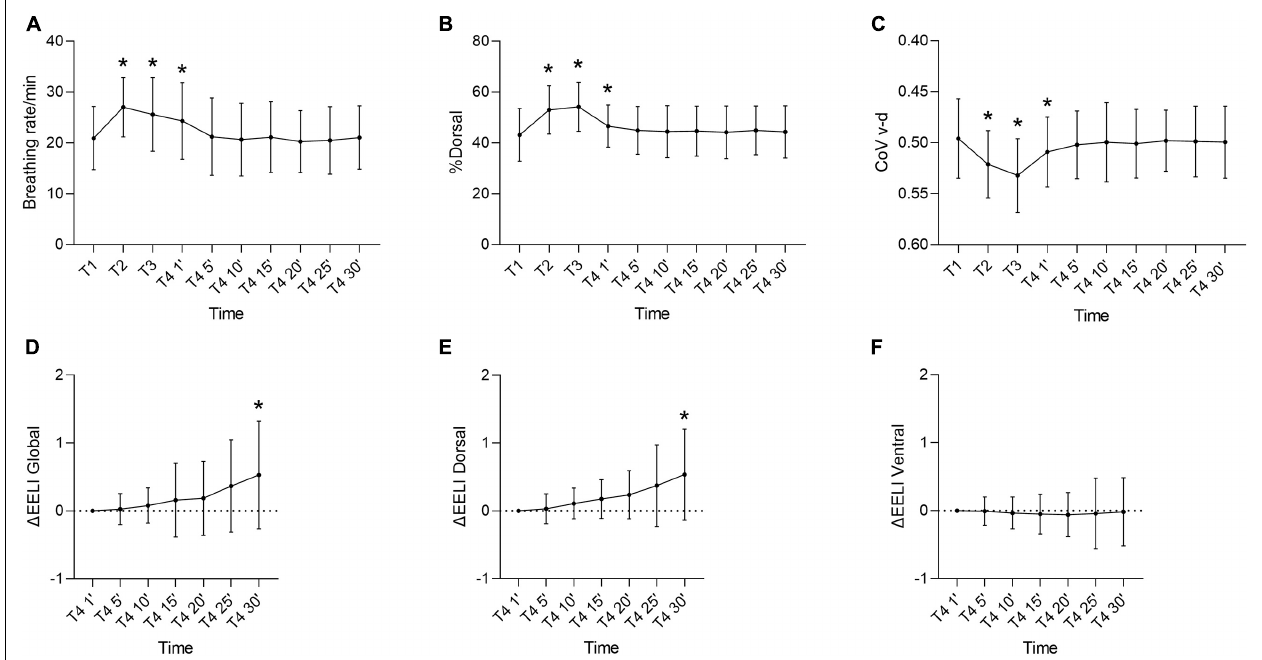
FIGURE 2 | (A) Breathing rate. (B) %Dorsal. (C) CoV v-d. Changes from T1 (Baseline) to T2 (start sitting position), T3 (end sitting position), and T4 (follow-up total 30 min). (D) (cid:49) EELI global. (E) (cid:49) EELI dorsal. (F) (cid:49) EELI ventral. Changes during Follow-up (T4), 1–30 min (1’–30’). Values are shown as Mean ± SD. %Dorsal, percentage of dorsal ventilation; CoV v-d, Center of ventilation ventral-dorsal; (cid:49) EELI, change in end-expiratory lung impedance; *, presentation of significant results in relation to T1.